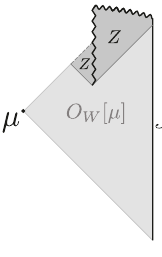
Figure 8 . Illustration of a coarse grained spacetime extended beyond Cauchy horizons into the dark gray regions. X 0 is an extremal surface that is a candidate HRT surface. Since X 0 must be homologous to both I and ˜ I , it will lie in D [Σ tot ] . µ must be spacelike to ˜ i + for any choice of extension M [ µ ] − D [Σ tot ] .